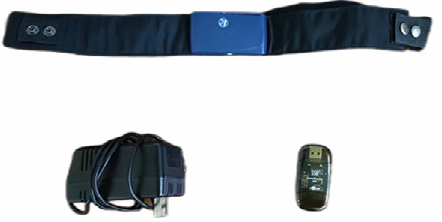
Figure 3. Equipment used in experiment: dynamic multi-parameter physiological detector.